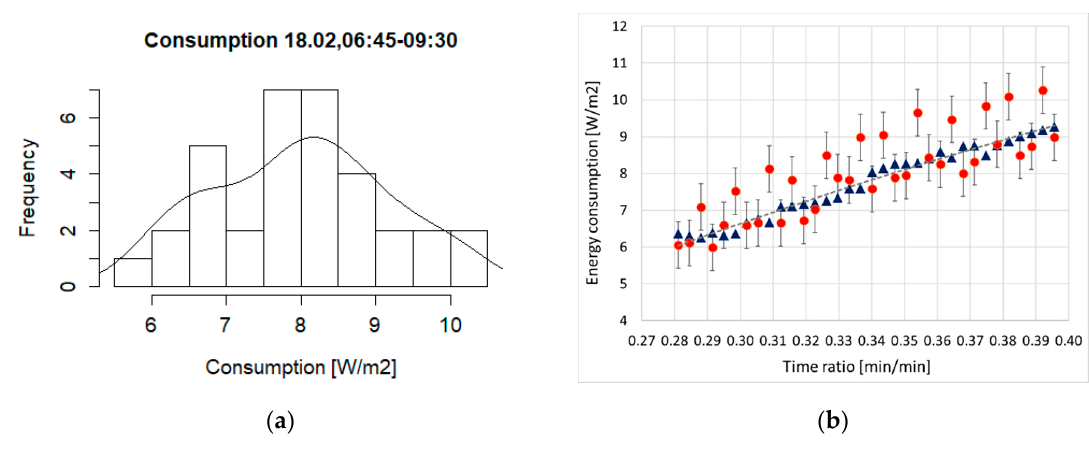
Figure 6. Arriving-at-work, 06:45–09:30: ( a ) Histogram for measurements; ( b ) smooth (triangles) vs. bare data (dots).